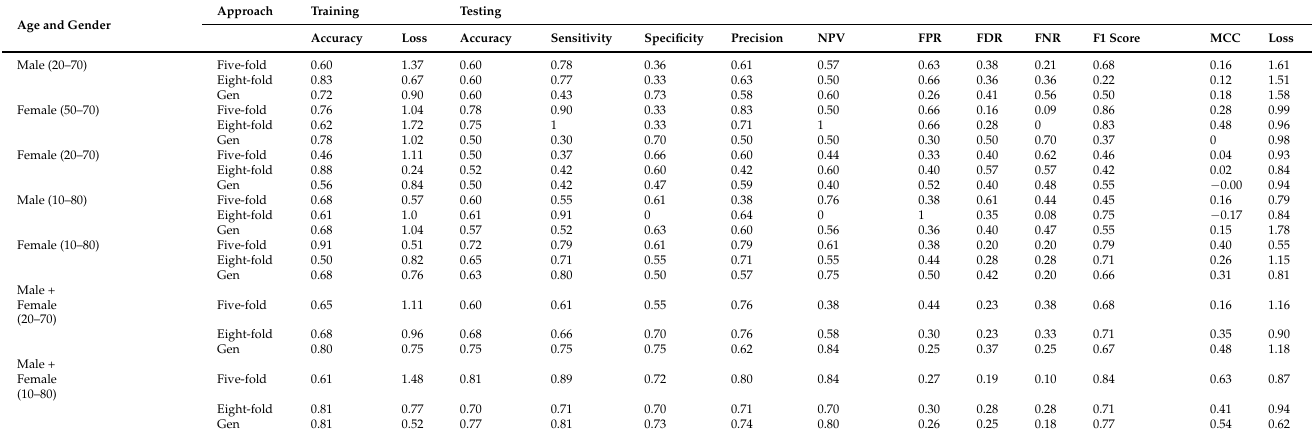
Table 6. AlexNet output using age and gender (Gen = Generalization approach).